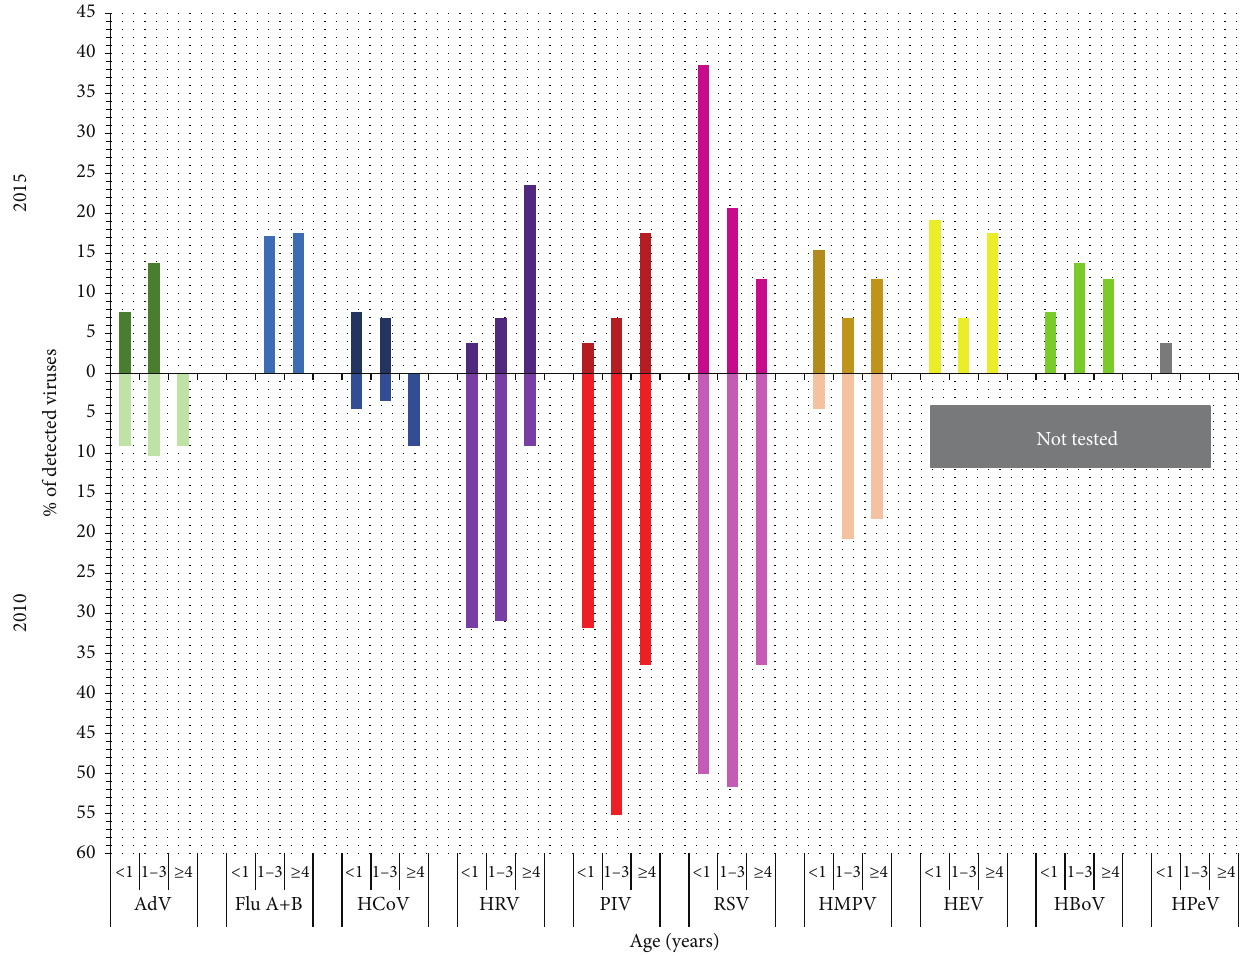
Figure 2: Viral incidence by patient’s age and viral type in 2010 and